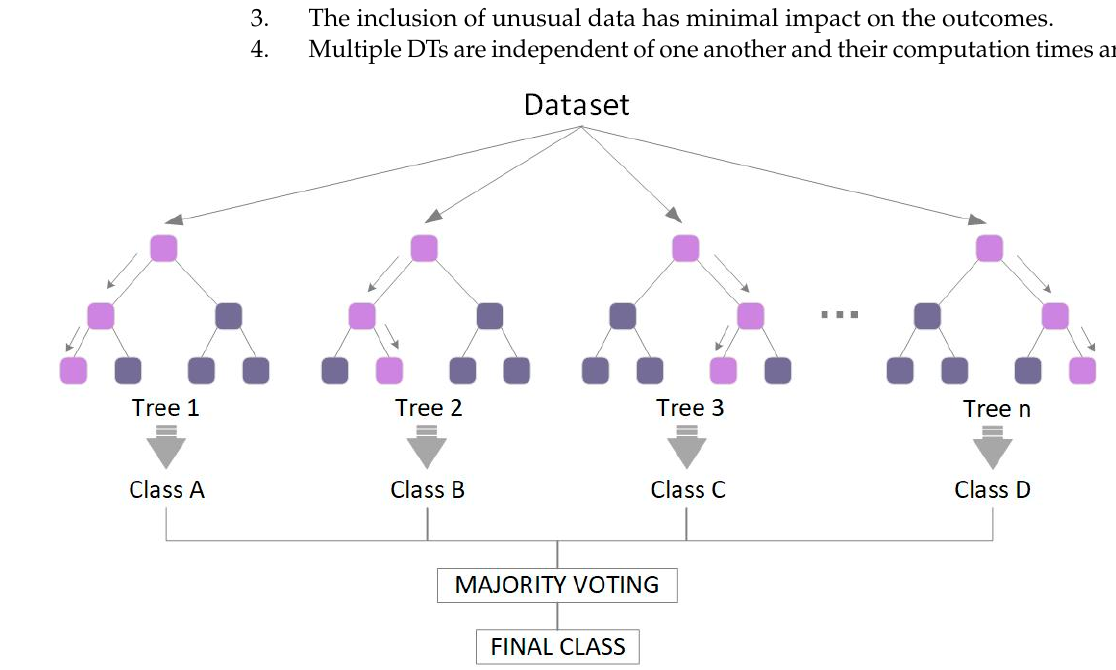
Figure 2. A typical architecture of RF. Note that the light purple block represents the best feature of the selected segmentation node